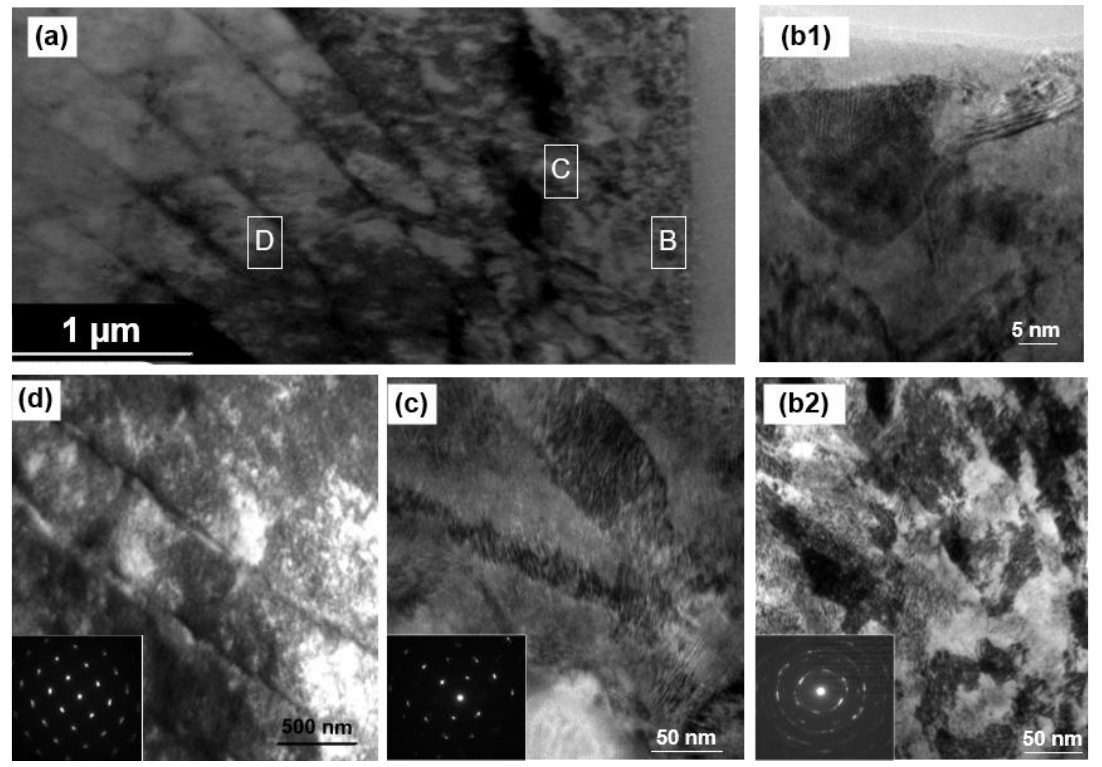
Figure 3. ( a ) TEM cross-sectional observation of the SMCGT sample; ( b–d ) TEM observations corresponding to the marked regions in ( a ): ( b1 ) and ( b2 ) in region B (0 to 0.5 µm deep from the surface), ( c ) in region C (1 µm deep from the surface), and ( d ) in regions D (2 to 3 µm deep from the surface)